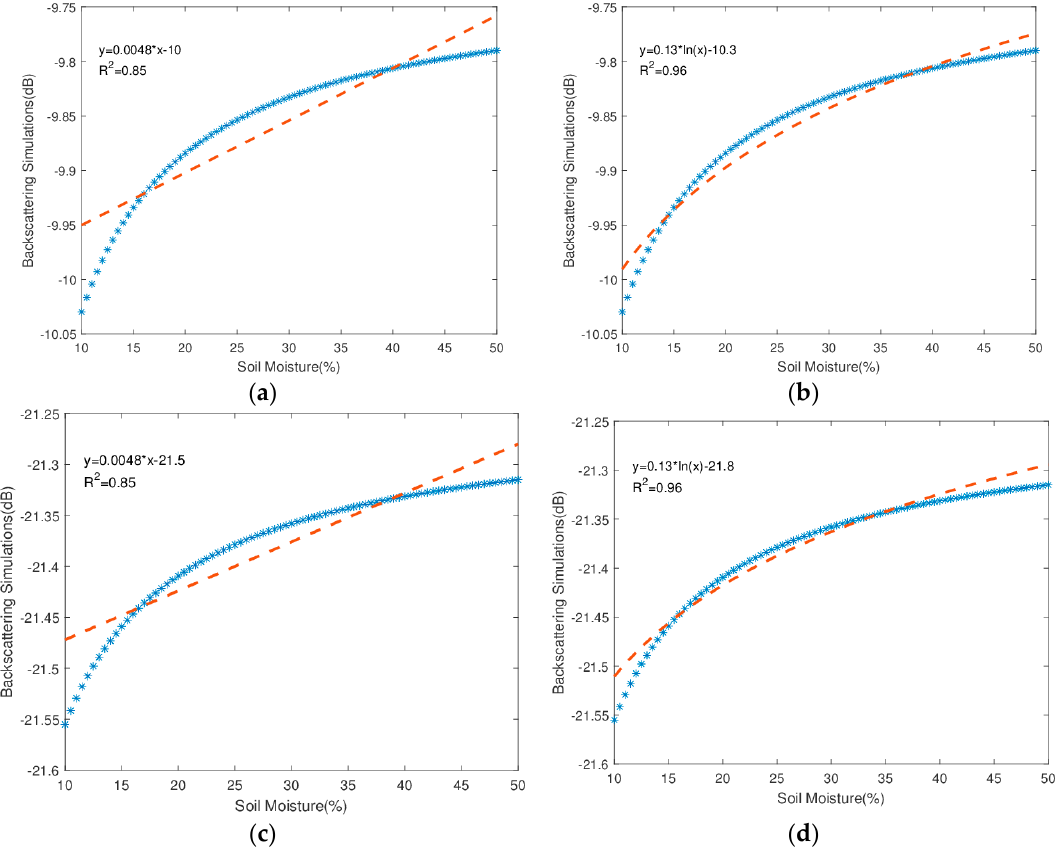
Figure 4. CIEM simulations of the backscattering signal with soil moisture in different fitting relationships (linear and logarithmic) in VV and VH polarizations: ( a ) VV, linear; ( b ) VV, logarithmic; ( c ) VH, linear; ( d ) VH, logarithmic.